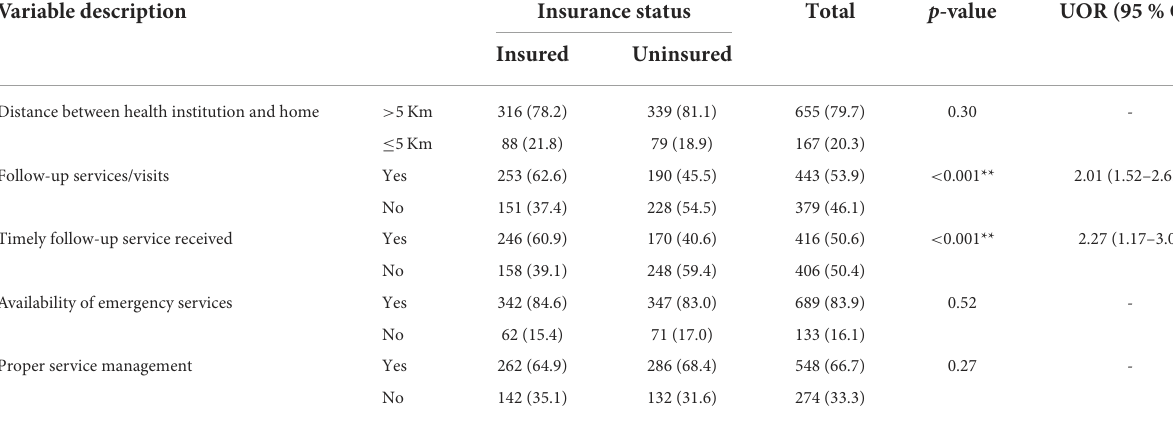
TABLE 3 Associative supply-side quality and availability factors of insurance providing